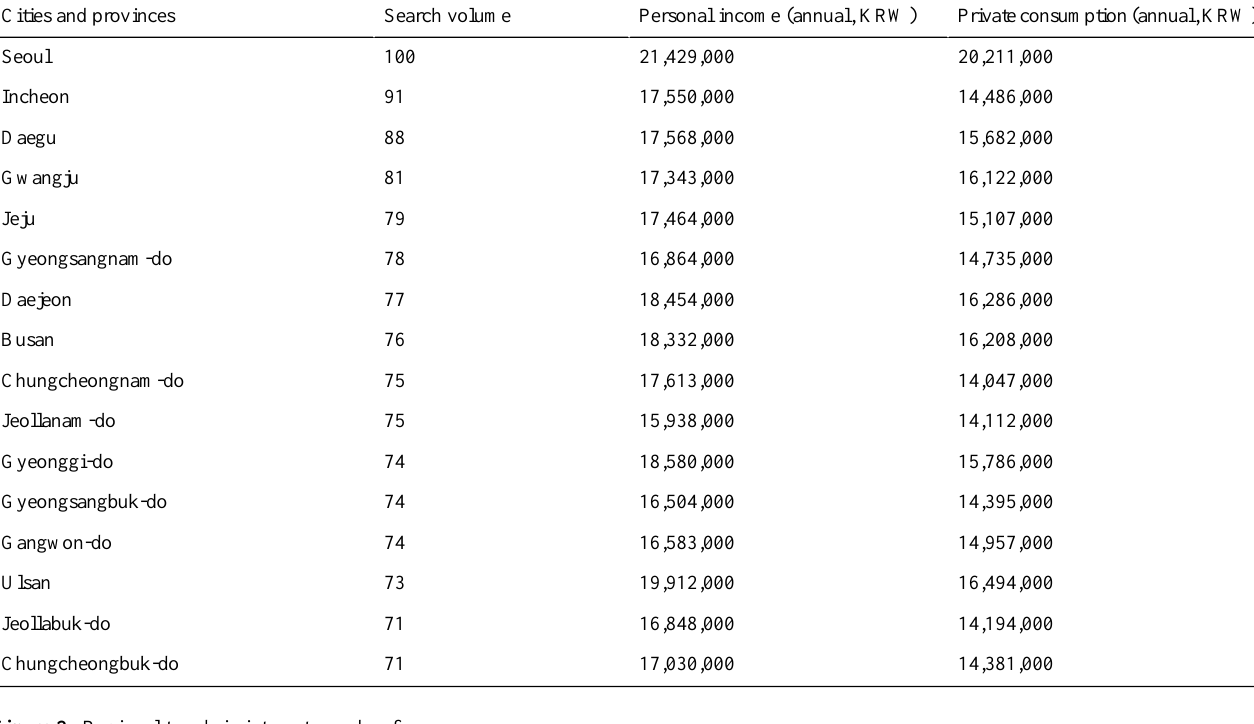
Table 1. Acne vulgaris search volume and personal income in cities and provinces.